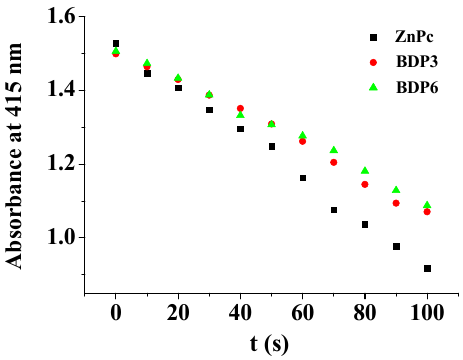
Figure 2. Comparison of the degradation rates of 1,3-diphenylisobenzofuran (DPBF) in DMF as monitored spectroscopically at 415 nm, using BDP3 and BDP6 as the photosensitizers and unsubstituted zinc(II) phthalocyanine (ZnPc) as the standard.